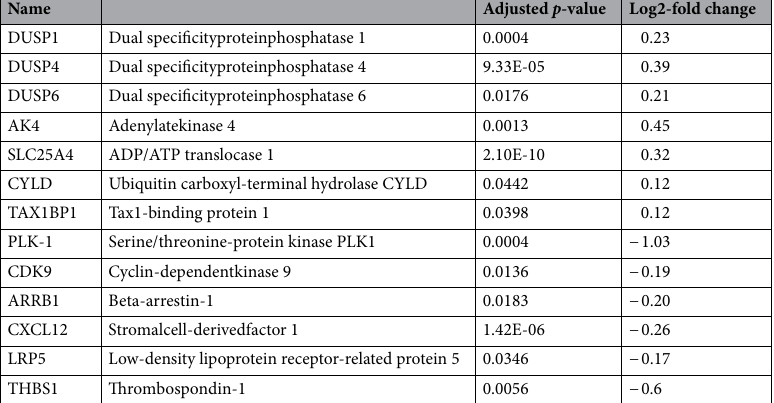
Table 2. Genes associated to inflammation and cell death. Selection of DEG’s annotated to significantly enriched GO-terms associated to the actin cytoskeleton. The portrayed genes were selected due to possible biological significance for podocyte health. Adjusted p -value was considered significant at p <